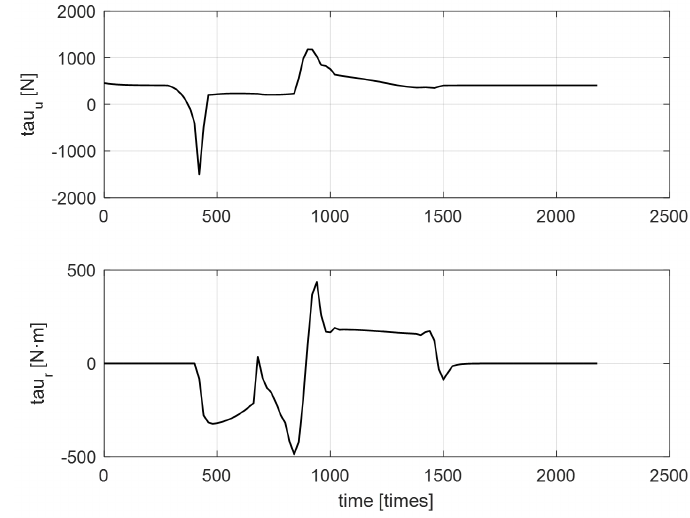
Figure 14. Variability in control in static collision avoidance.